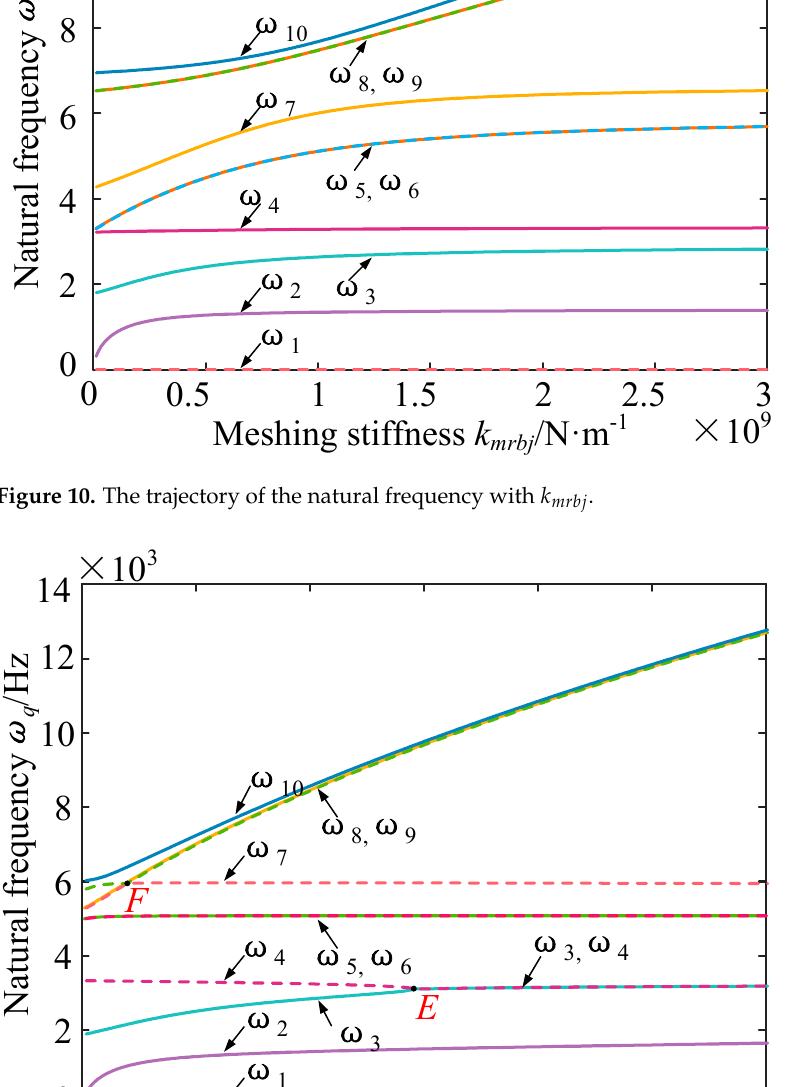
Figure 11. The trajectory of the natural frequency with k mabj